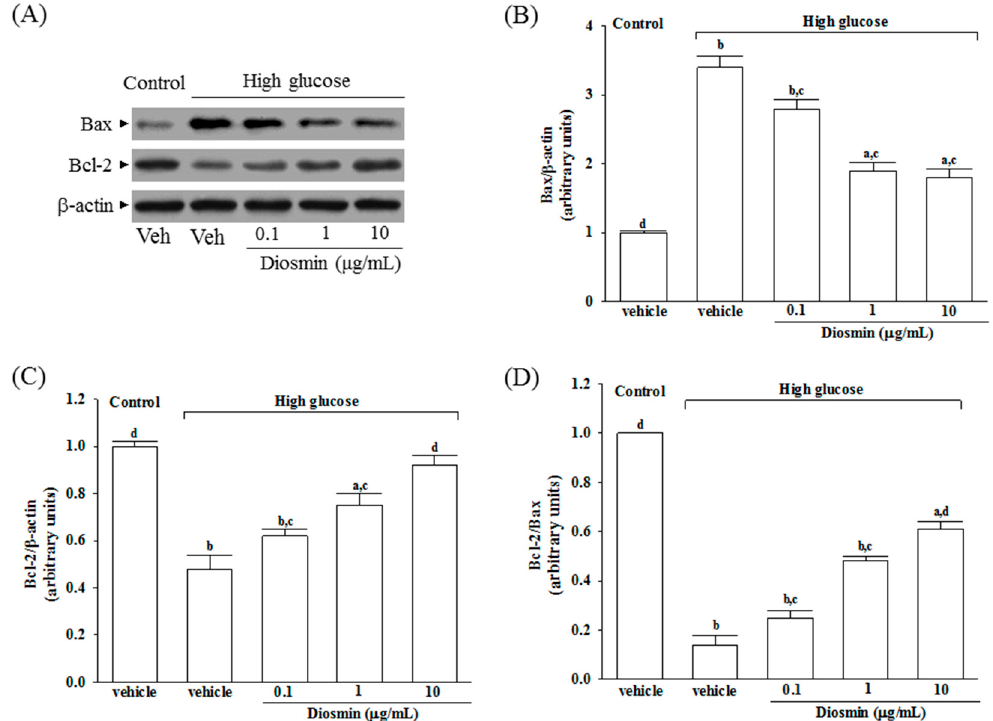
Figure 4. Effect of diosmin on Bax and Bcl-2 expression in high glucose cultured ARPE-19 cells. ( A ) The photographs were representatives the Western blots for Bax and Bcl-2 protein. Five western blots per group were experimented; ( B ) Relative intensities of Bax protein (fold to β -actin); ( C ) Relative intensities of Bcl-2 protein (fold to β -actin); ( D ) Ratio of the relative intensities of Bcl-2 to Bax (Bcl-2/Bax). Each column represents means ± SD ( n = 5 per group). a p < 0.05 and b p < 0.01 compared with normal-glucose vehicle-treated group (control), respectively. c p < 0.05 and d p < 0.01 compared with high-glucose vehicle-treated group, respectively.